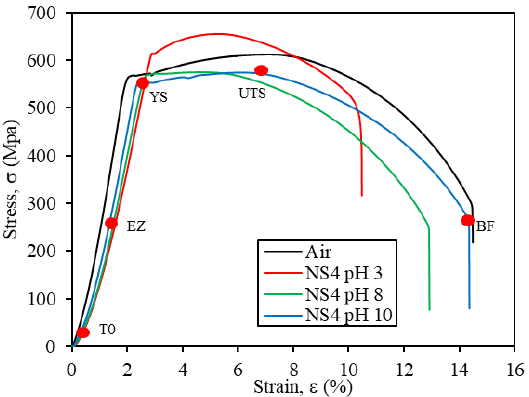
Figure 2. Stress-strain curves of X70 steel obtained in air and in the NS4 solution at different pH values.